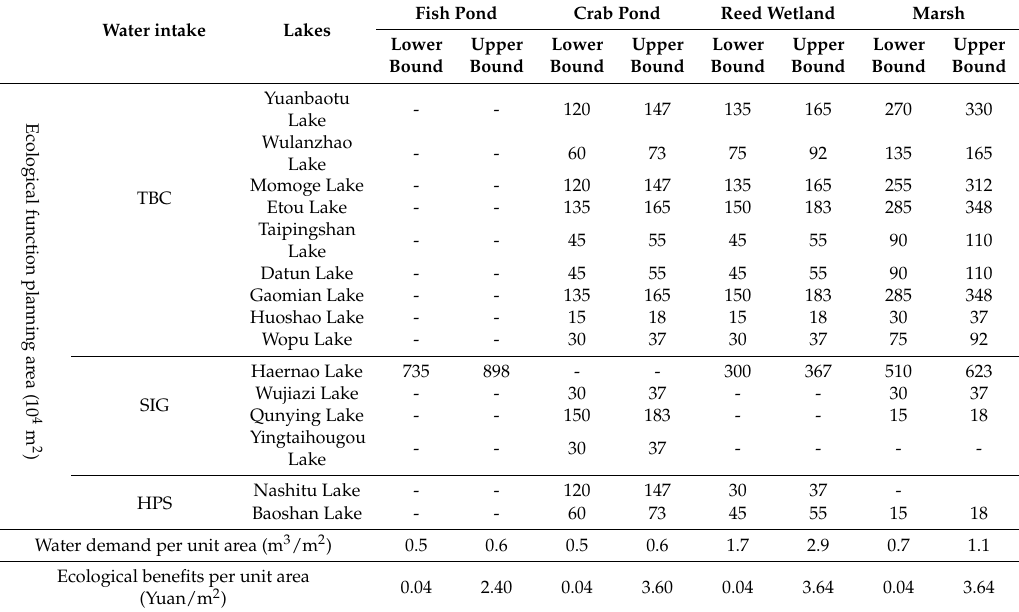
Table 3. Ecological function planning area, water demand and ecological benefits per unit area.